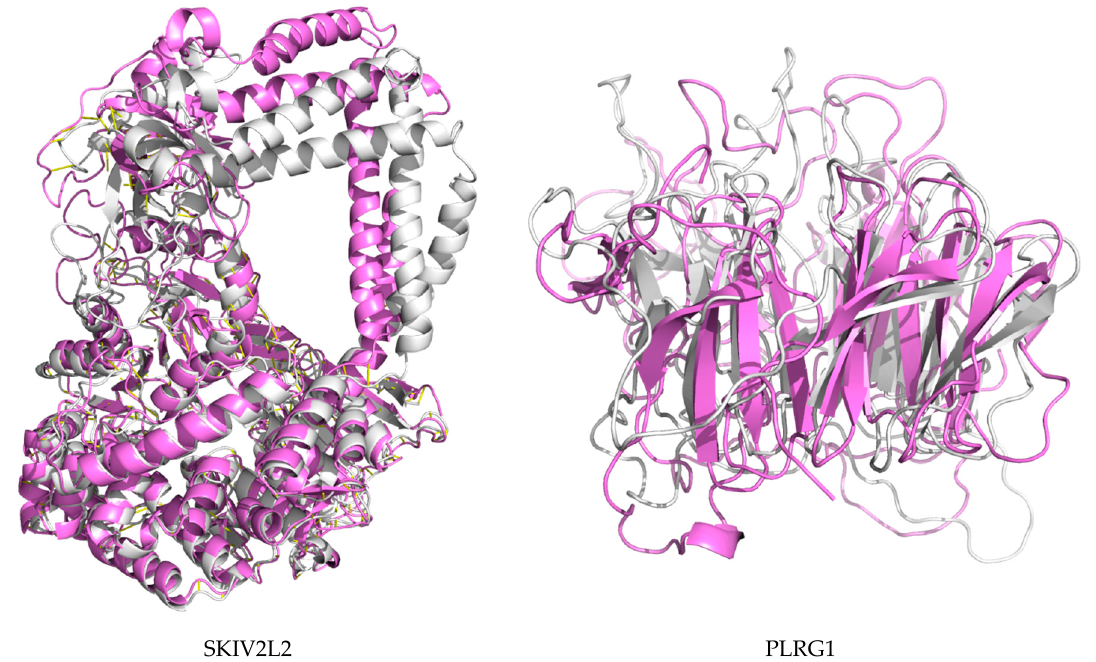
Figure 7. Superposition of the primarily modeled structure (gray) and the MD-optimized protein structure (violet). Yellow: partially mixed area.